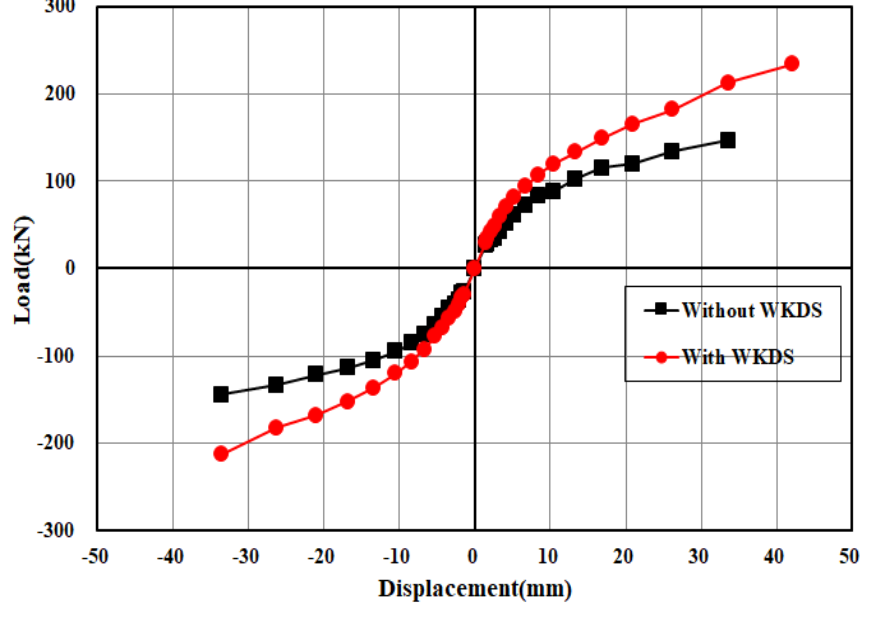
12 of 25 Figure 12. Hysteretic curves of the RC frames with and without the WKDS. Table 3. Yields and maximum loads and displacements of the RC frames with and without the WKDS. Specimen